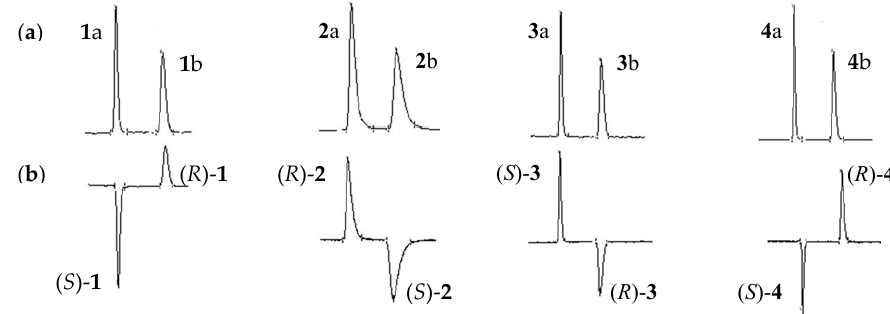
Figure 2. The UV ( a ) and ECD chromatograms ( b ) of racemic 1 – 4 on various columns. 1 on the ChiralPak AD-H column, 2 on the Chiralcel OD-H column, 3 on the ChiralPak AS-H column, and 4 on the ChiralPak AD-H column. Detection wavelengths of 1 – 4 are 275, 275, 240, and 285 nm, respectively.